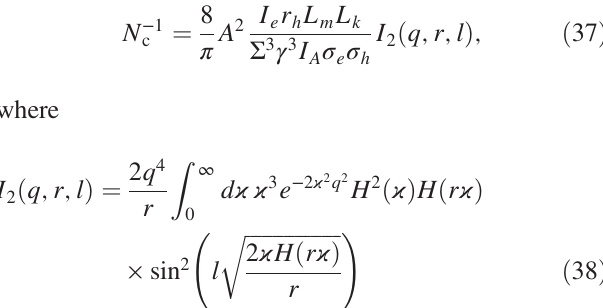
FIG. 7. Plot of the maximum values of I 2 the length l for r ¼ 0 . 2 , 0.6, and